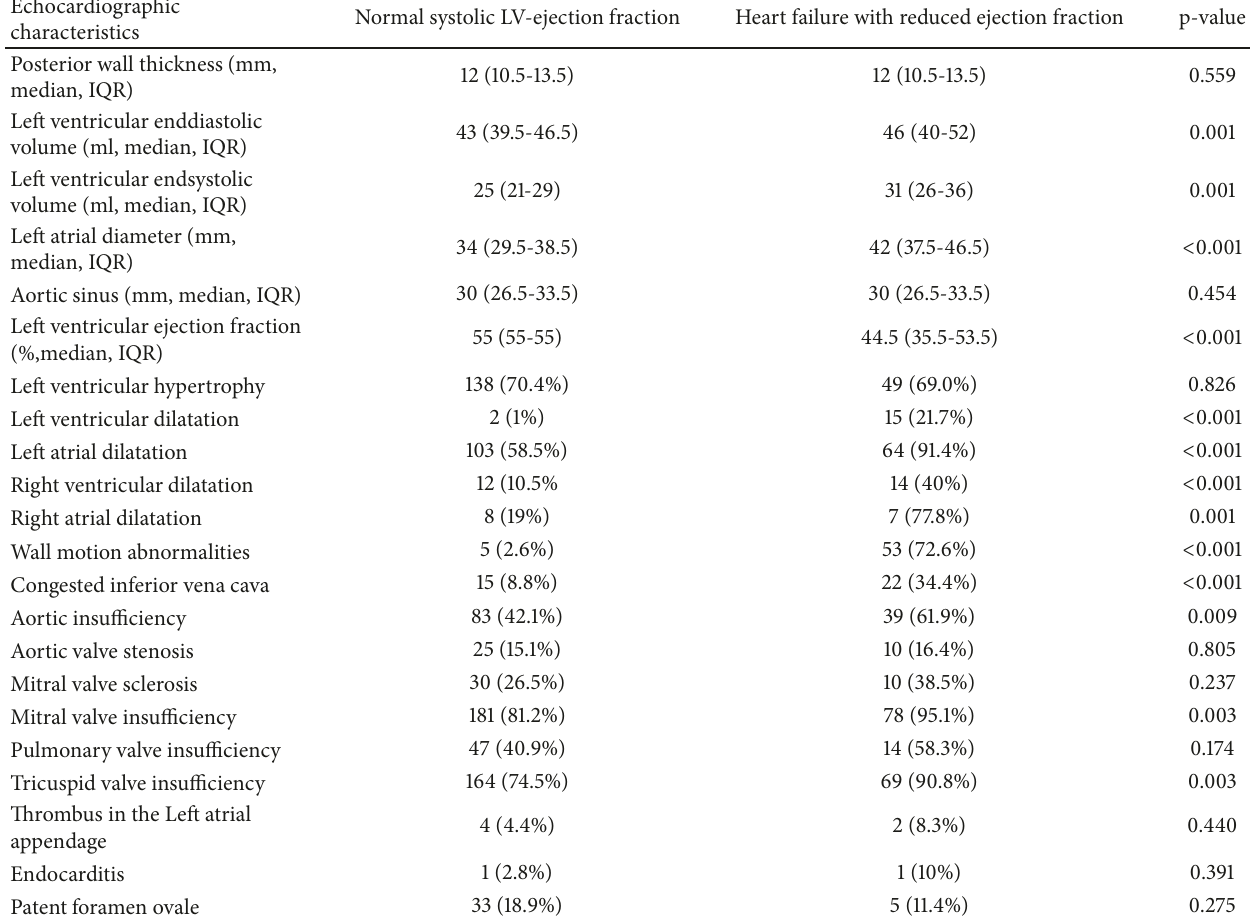
Table 2: Echocardiological characteristics of patients with and without hear